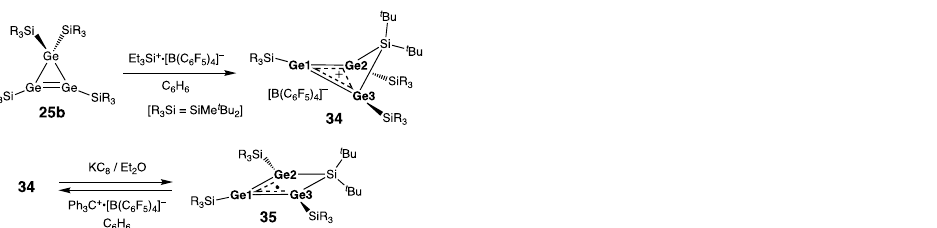
Scheme 15. Synthesis of tri(germa)allyl anion 32 . Most recently, Lee, Sekiguchi,